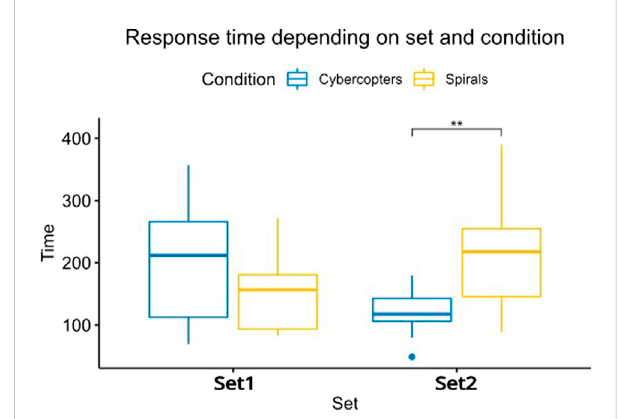
FIGURE 7 Response time to each alert depending on the set and interface.